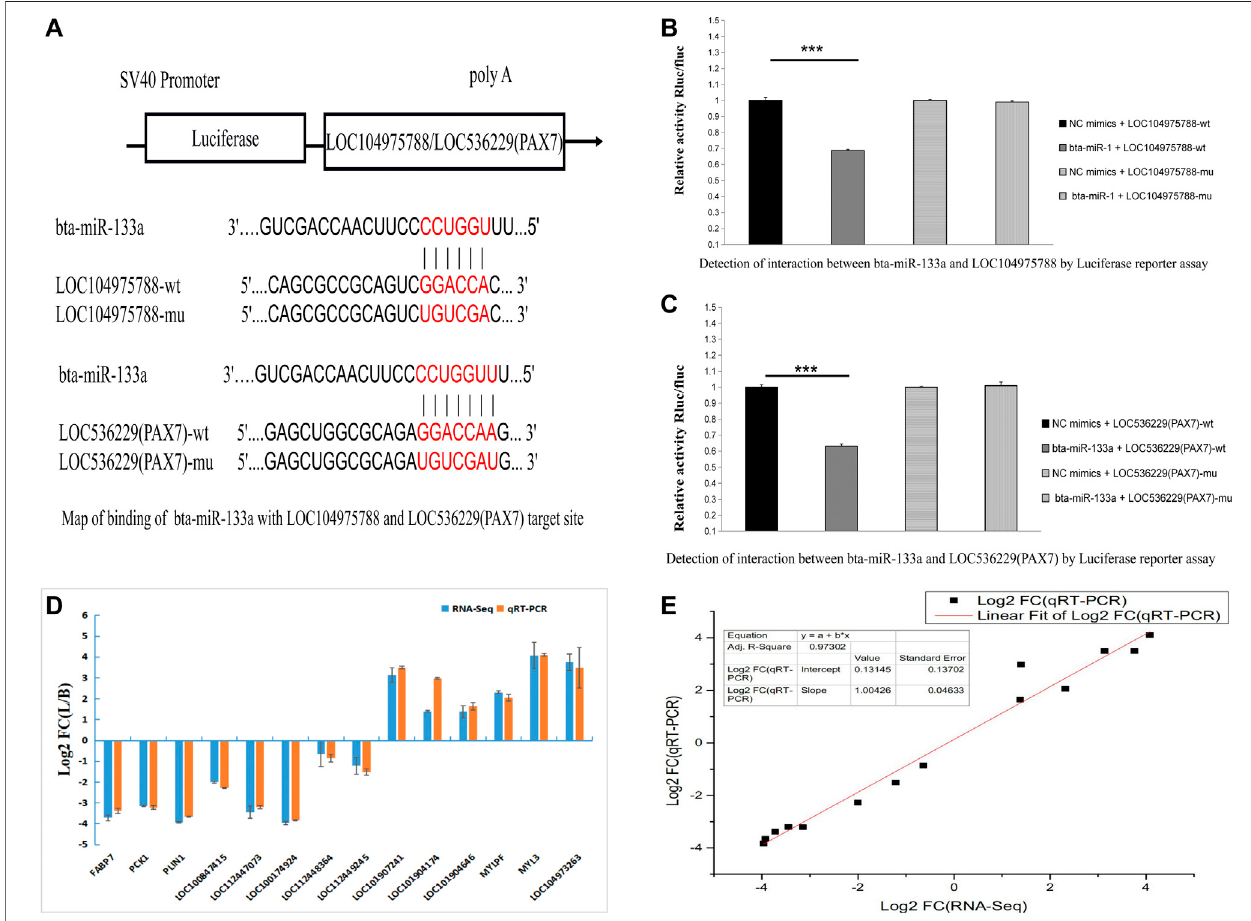
FIGURE 7 | Map of binding of bta-miR-133a with LOC104975788 and LOC536229 (Pax7) target site (A) . Luciferase reporter assay showed signi fi cantly lower luciferase activity of miR-133a co transfected with the psi-LOC112448162 vector compared to the control group ( p < 0.01). The luciferase activity of miR-133a co- transfected with psi-LOC536229 (Pax7) vector was also signi fi cantly decreased relative to the control Q19 group ( p < 0.01) (B, C) . These results indicate that both LOC104975788 and LOC536229 (Pax7) contain miR-133a binding sites. Nine differentially expressed LncRNAs and fi ve differentially expressed mRNAs were veri fi ed by qRT-PCR (D, E)